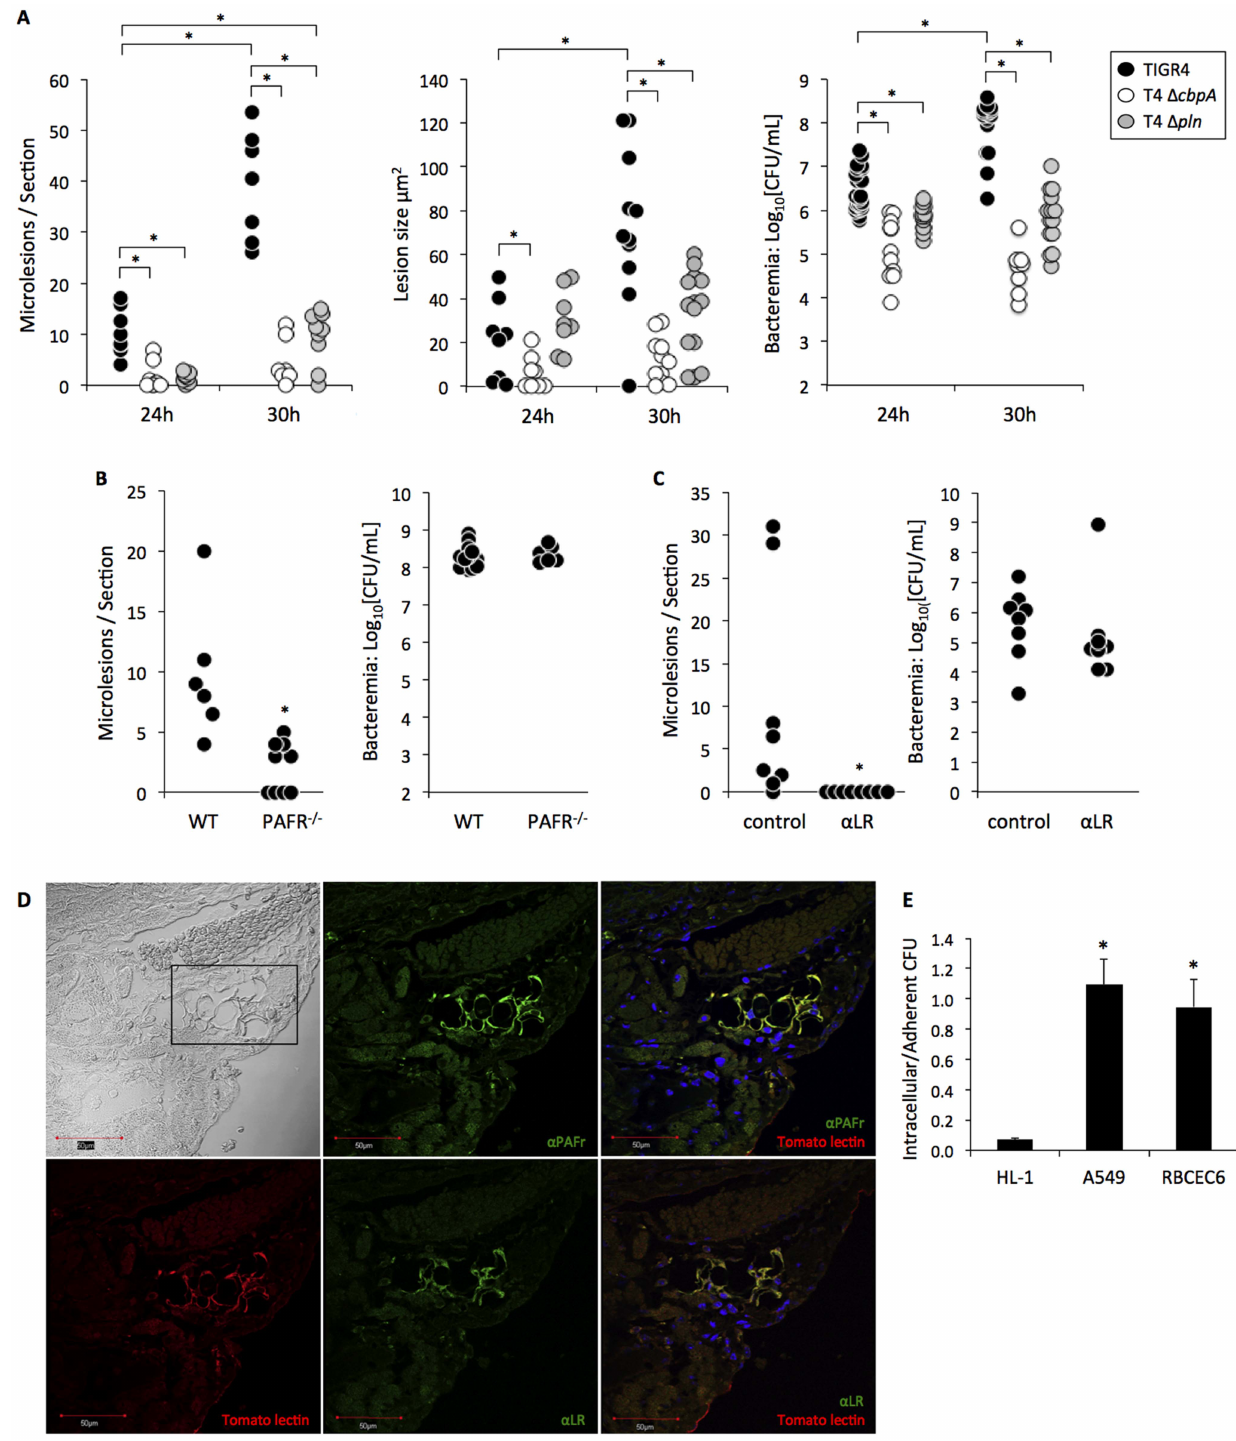
Figure 3. Lesion formation is dependent on the host protein PAFR and the bacterial adhesin CbpA. A) Total counts, size of lesions, and bacterial burden in BALB/c mice infected with TIGR4 (24 h n=8; 30 h n=12), T4 D cbpA (24 h n=8; 30 h n=13), and T4 D pln (24 h n=8; 30 h n=15) post-infection. B) Counts of cardiac lesions and bacterial burden found in sections from TIGR4 infected wild-type C57BL/6 (n=6, n=13, respectively) and PAFR 2 / 2 (n=9, n=6, respectively) mice. C) Cardiac lesions and bacterial titers in the blood in TIGR4 infected BALB/c mice following passive immunization with monoclonal antibodies against LR (anti-LR n=8) or with an isotype control (n=8). D) Immunofluorescence microscopy of a cardiac section treated with FITC conjugated anti-PAFr or anti-LR antibodies in addition to tomato lectin that is selective for vascular endothelial cells. DAPI was used to stain nuclei. Top left image was taken under bright field with the rectangle indicating the location of cardiac blood vessels. Note that on overlaid images of the same tissue section PAFR and LR were found primarily on the vascular endothelial cells and not on cardiomyocytes. E) Comparison of pneumococcal invasion rates into rat HL-1 cardiomyocytes, human type II pneumocytes (A549) and rat brain endothelial (RBCEC6) cell